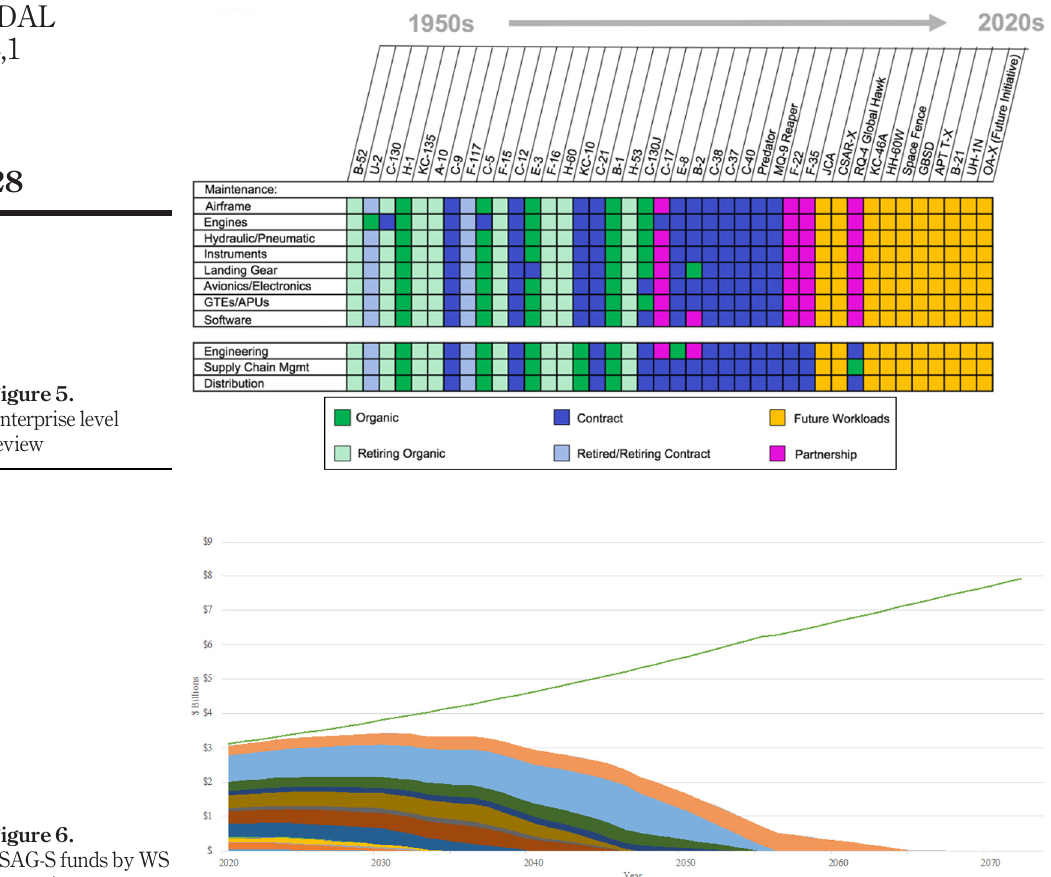
Figure 6. CSAG-S funds by WS over